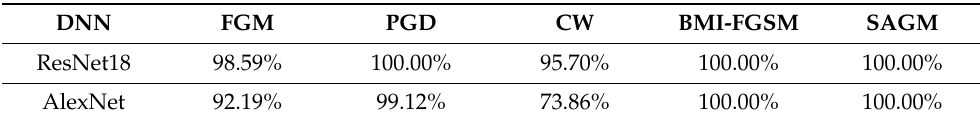
Table 2. Attack Success Rate on the CIFAR10 Dataset.